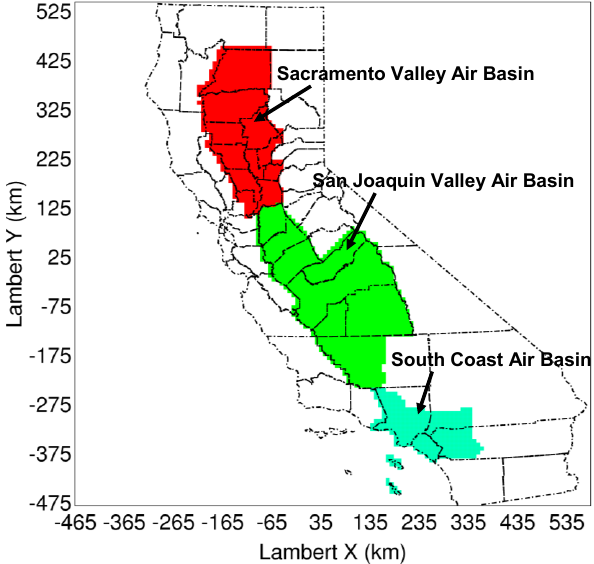
Fig. 1. Three major air basins in California: (1) Sacramento Valley Fig.1. Three major air basins in California: (1) Sacramento Valley Air Basin (SV), (2) 662 Air Basin (SV), (2) San Joaquin Valley Air Basin (SJV), and (3) San Joaquin Valley Air Basin (SJV), and (3) South Coast Air Basin (SoCAB). Note that 663 South Coast Air Basin (SoCAB). Note that the lines in the state the lines in the state map represents county boundaries in California. 664 map represents county boundaries in